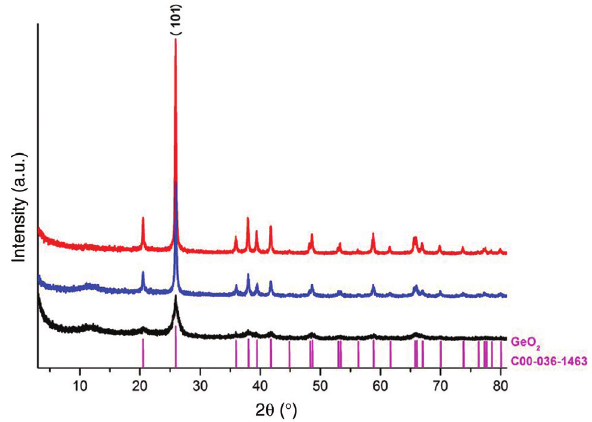
Figure 1 X-ray powder diffraction pattern of the as-prepared β -GeO particles. The red, blue and black curves depict the X-ray powder diffraction patterns of the GeO particles of samples A , B and C . The 2 violet bars display the standard diffraction pattern of hexagonal β -GeO (ICDD no. 2